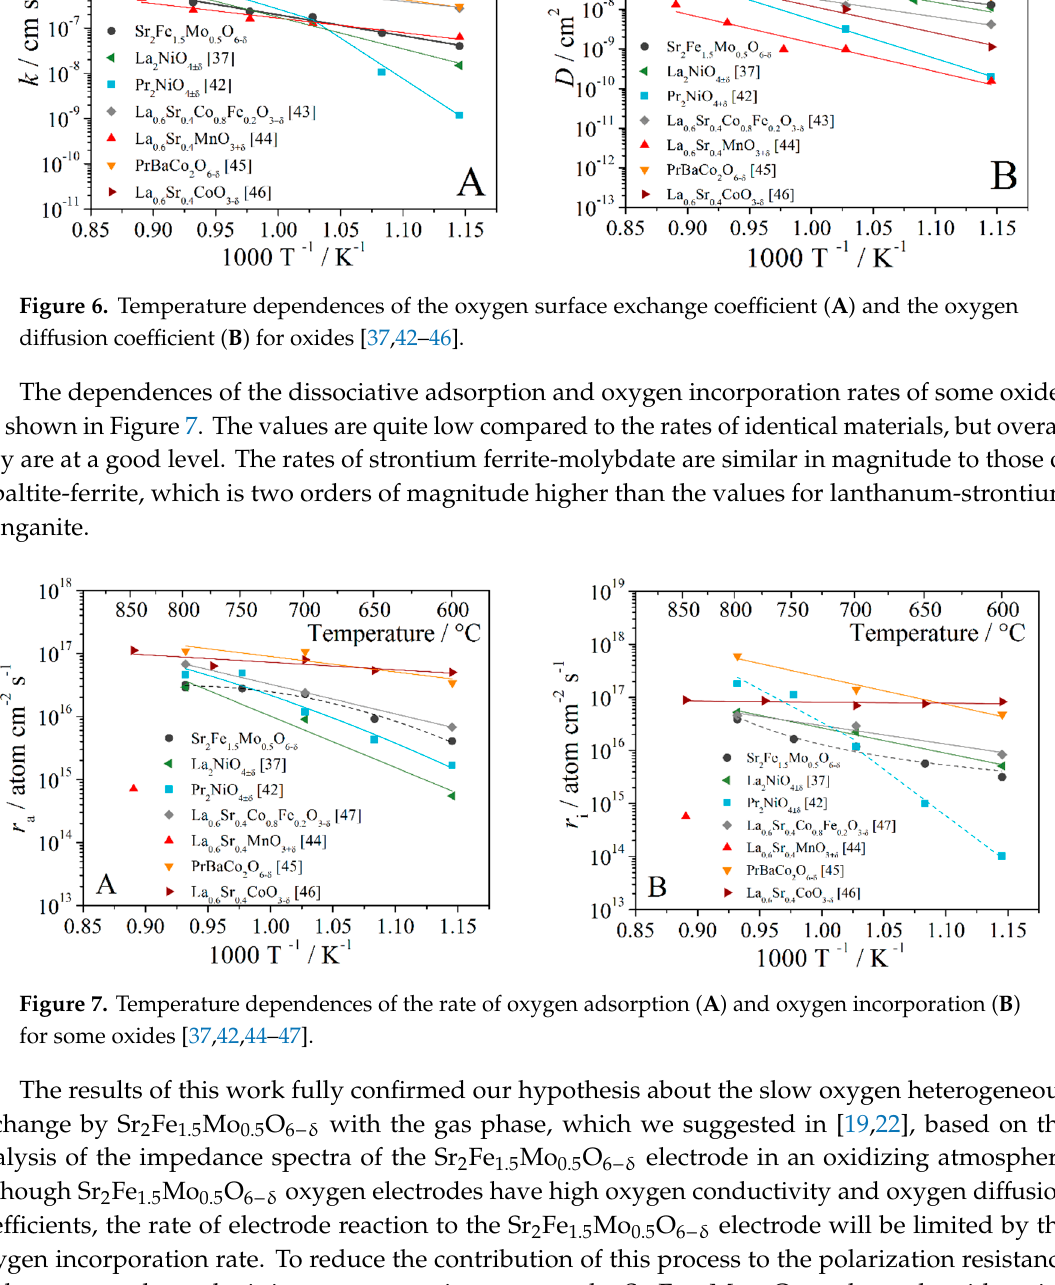
Figure 6. Temperature dependences of the oxygen surface exchange coefficient ( A ) and the oxygen diffusion coefficient ( B ) for oxides [37,42–46].